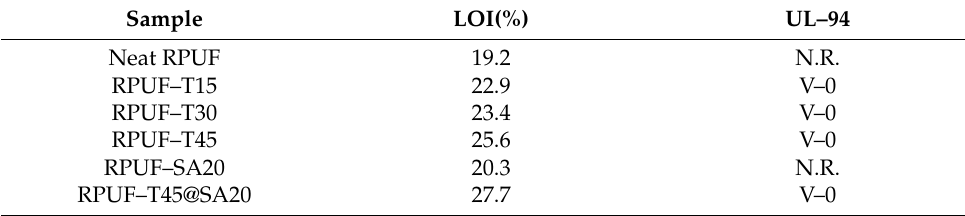
Table 5. LOI values and UL–94 grades of